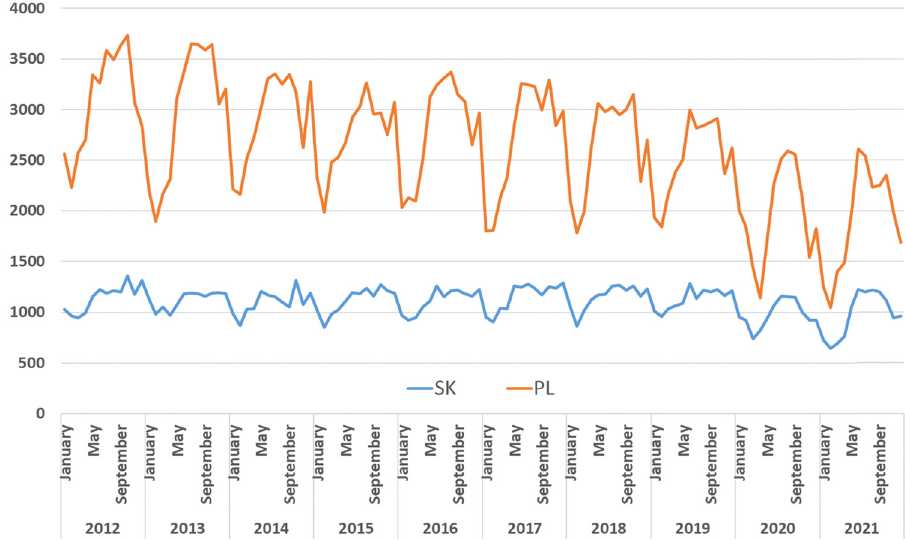
Figure 1: Comparison of the number of tra ffi c accidents in Poland and Slovakia in 2012 – 2021 [ 55,56 ]